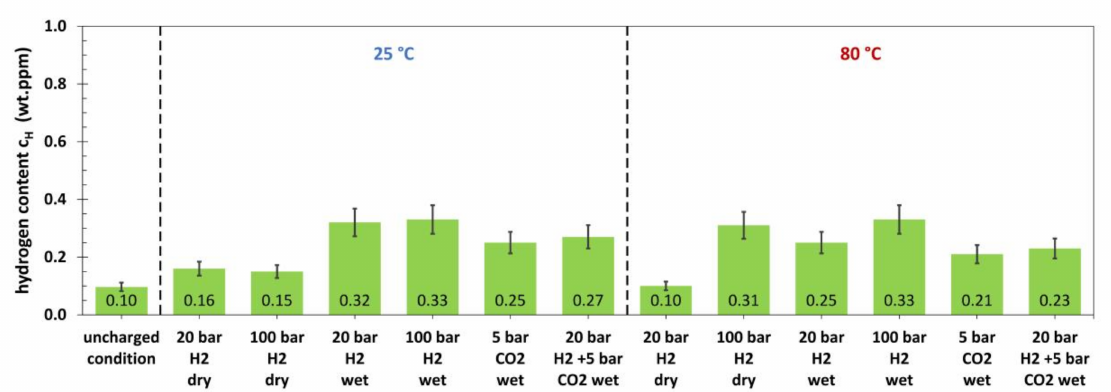
Figure 4. Hydrogen content of L80 after 30 days of autoclave testing with various media at 25 ◦ C and 80 ◦ C (wet conditions: with electrolyte; 15,000 ppm Cl − ).